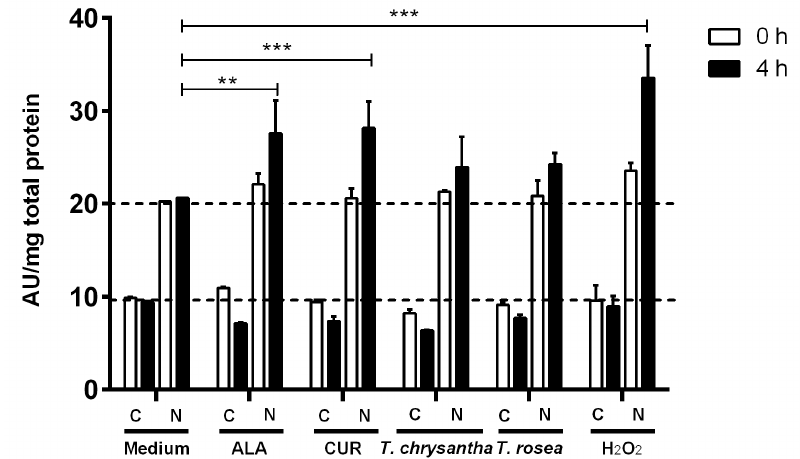
Figure 1. Nrf2 levels in cytosol (C) and nucleus (N) after 0 (white bars) and 4 hours (black bars) exposure to 50 mM ALA, 15 mM CUR, ethyl acetate extracts from T. chrysantha (0.5 µg/mL) and T. rosea (1 µg/mL) and induction of oxidative stress with 0.6 mM H Wallis ** p <0.01, *** p <0.001. ALA: Alpha-lipoic acid; CUR: